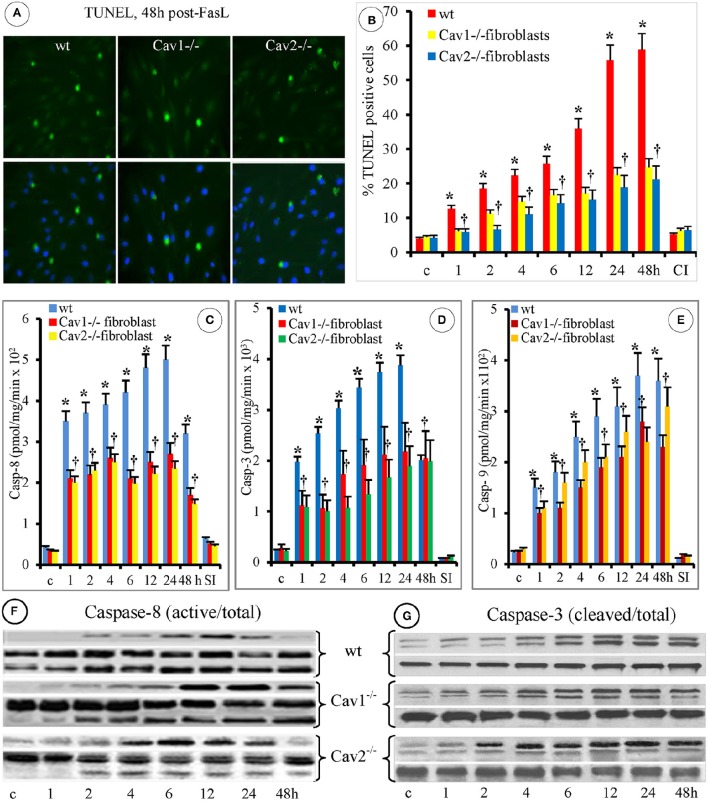
FasL-induced apoptosis of mouse fibroblasts is caspases-dependent. (A) The upper panels illustrate the TUNEL staining of mouse fibroblasts at 48 h post- FasL treatment; while the lower panels illustrate the DAPI staining for the detection of cellular nuclei. Bar: 30 mm, n = 7. (B) Morphometric analyses of TUNEL-positive fibroblasts at different time points after FasL exposure. Note that at 48 h after FasL, the progression of apoptosis is inhibited by 30 μ of pan caspases inhibitor MZ-VAD-FMK (CI); n = 4 for every time point and type of fibroblasts, *p < 0.05 when wt-fibroblasts are contrasted with Cav-null fibroblasts. (C) Caspase-8 specific activity shows statistical differences between wt- and Cav-null fibroblasts (*p < 0.05), and no significant differences between Cav-null fibroblasts, †p < 0.26; n = 6 for each type of fibroblasts. (D) Caspase-3 activity was higher in wt-fibroblasts when compared with cav null fibroblasts, *p < 0.05. Its activity was slightly higher in Cav1−/− compared to Cav2−/− fibroblasts, but without statistical significance, †p < 0.14; n = 6 for each type of fibroblasts. (E) The higher activity of Caspase-9 in the first 24 h reached statistical significance for wt-fibroblasts when compared to Cav1−/− fibroblasts, *p < 0.05, but not when compared with Cav2−/− fibroblasts; p < 0.1; its activity was not different between Cav1−/− and Cav2 −/− fibroblasts, †p < 0.22. n = 9 for each type of fibroblasts. (F) Activation of Caspase-8 (top panels) was evident by 2 h in all types of fibroblasts, peaked between 6 and 12 h post treatments and remained evident in cav null fibroblasts even beyond 24 h, while its total amounts didn't change over time. (G) Activation of Caspase 3 (top panels) was delayed, but evident by 4 h and persisted for 48 h. The data from F and G are representative for three experiments for every time point, repeated three times.